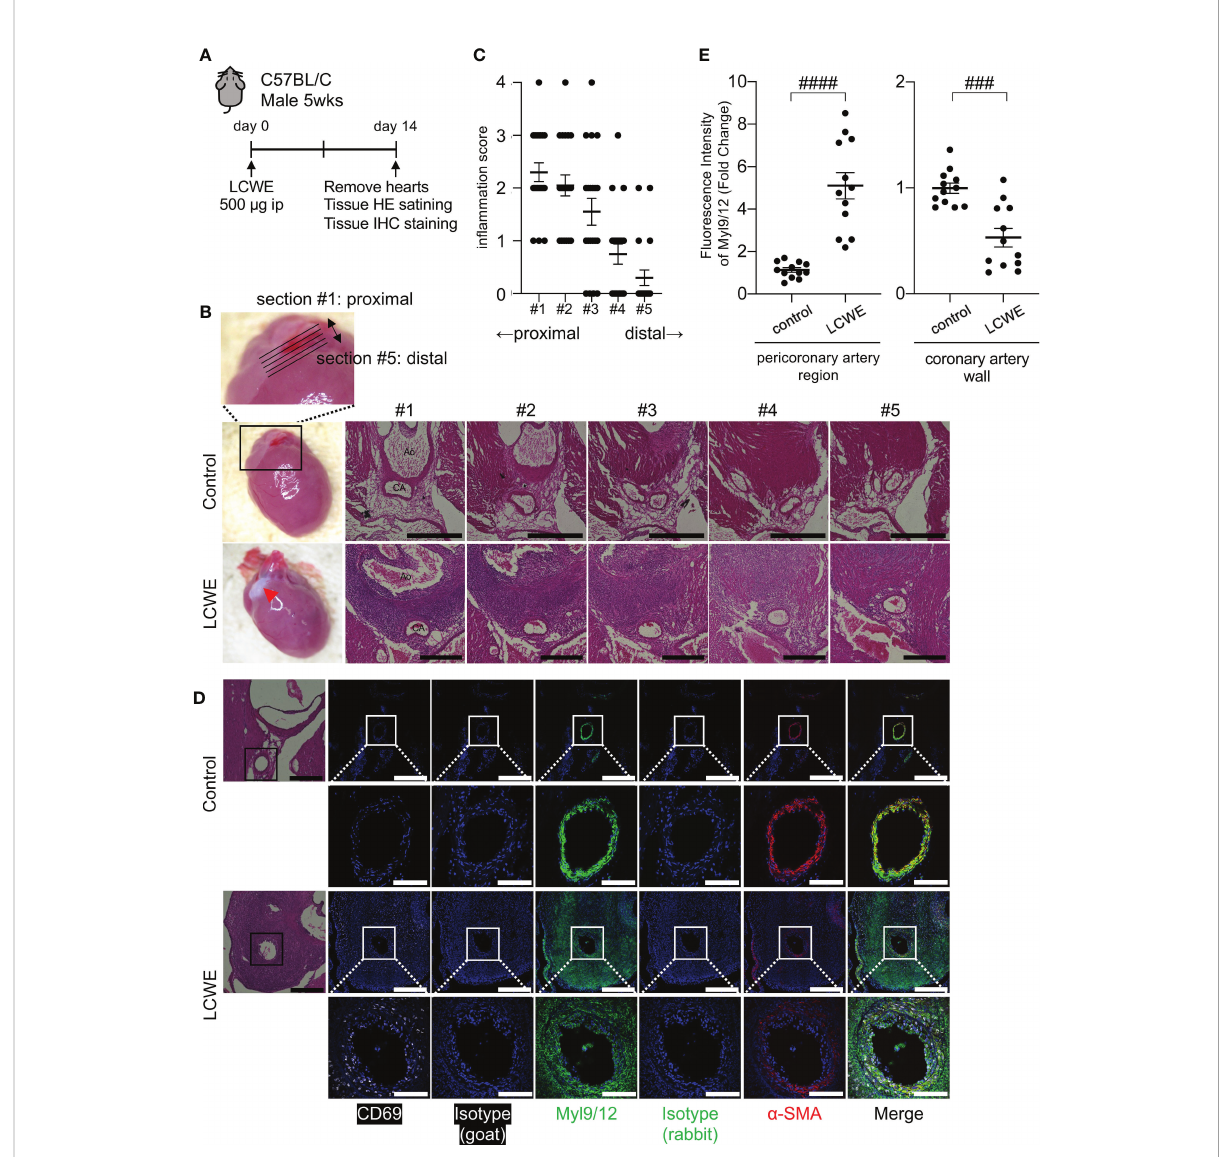
FIGURE 3 Myl9/12 expression in coronary arteries of LCWE-injected mice. (A) Schematic outline of the LCWE-induced KD vasculitis murine model. Five- week-old WT male mice were intraperitoneally (i.p.) injected with 500µg of LCWE and 14 days later heart tissues were collected and analyzed. (B) Representative pictures of heart tissues collected from control mice and LCWE-injected mice developing vasculitis (left). HE staining of serial sections of coronary arteries of a control mouse (upper) and a LCWE-injected mouse (lower). Five consecutive sections were prepared at 100 m m intervals from the proximal side of the coronary artery origin (section #1) to the distal side (section #5) as shown in the enlarged photograph (upper). Red triangle indicates in fl ammatory change. Black scale bars indicate 500 m m. CA, coronary artery; Ao, aorta. (C) The in fl ammation scores of serial sections of coronary arteries of the LCWE-injected mice in B are shown (100 tissue sections from 20 mice). Each dot shows the in fl ammation score from each section. (D) HE staining (left) and IHC staining of the coronary artery in a control mouse (upper) and an LCWE- injected mouse (lower) using goat anti-CD69 Ab (white), goat IgG isotype Ab, rabbit anti-Myl9/12 Ab (green), rabbit IgG isotype Ab, and anti- a - SMA Ab (red). The coronary artery is surrounded by a black (HE) or white square (IHC), and the indicated area is shown in a high-power fi eld (lower). Scale bars indicate 500 m m (low-power fi eld) and 100 m m (high-power fi eld). (E) The fl uorescence intensity of Myl9/12 in the pericoronary artery region (left) and coronary artery wall (right) using the section #1, comparison between control mice (n=12), and LCWE- injected mice (n=12), normalized to isotype controls was shown. Data are shown as the mean ± SEM. #### P < 0.0001 (single comparisons, Mann-Whitney U test without correction), ### P < 0.001. Data are shown as the mean ±